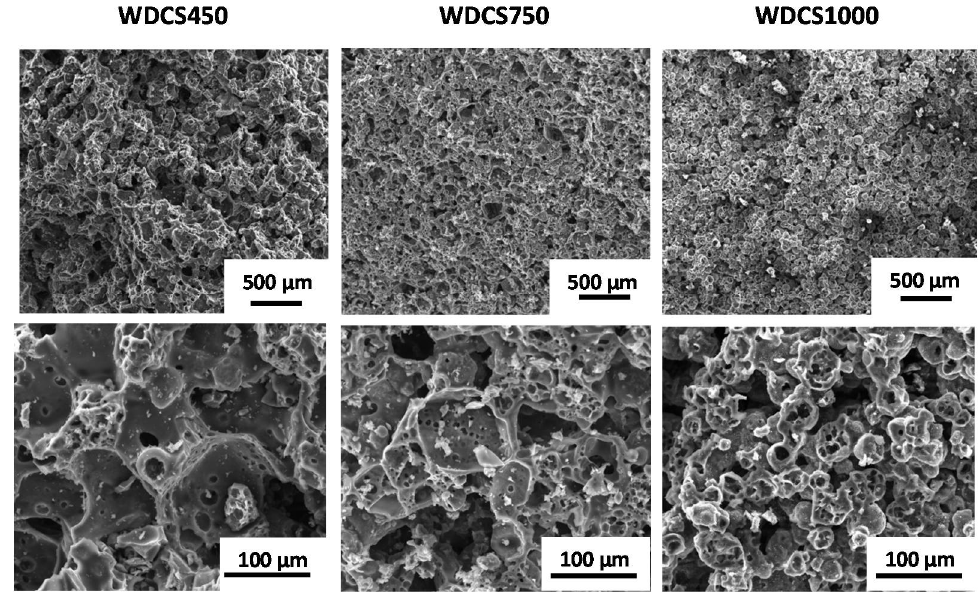
Figure 2. FESEM micrographs of scaffolds obtained from the sintering of whey powder at 450 °C, 750 °C and 1000 °C. Scale bars: 500 µm (top images); 100 µm (bottom images). Table 1. Densities, porosity, permeability, predominant, maximum and minimum pore sizes and linear shrinkage of the WDCSs.